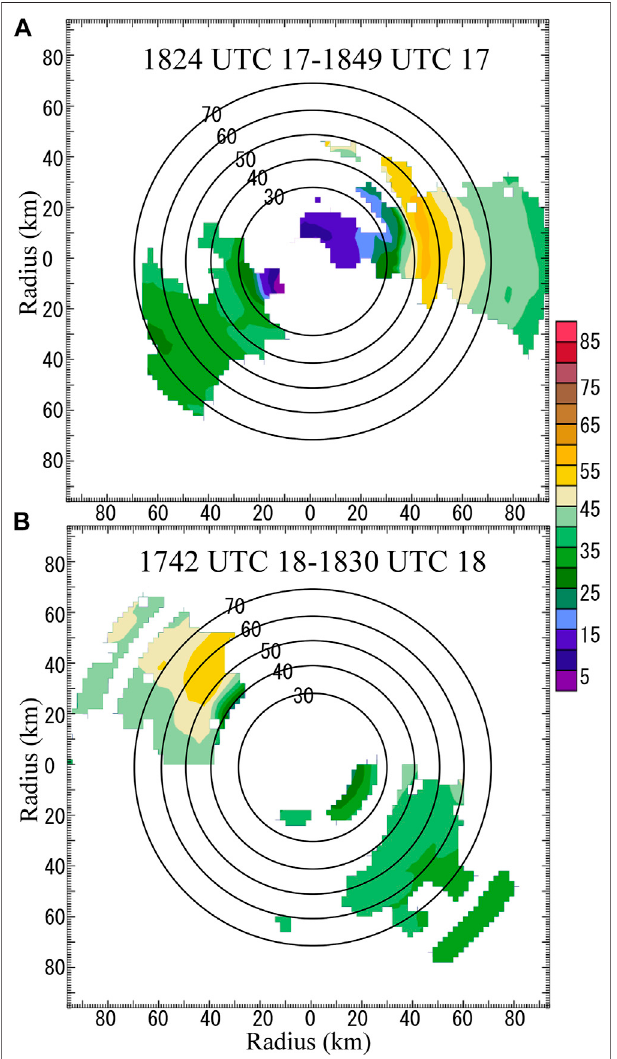
FIGURE 3 | Horizontal distribution of the 0.5-km wind (shaded, m s − 1 ) from the NOAA 42 Airborne Doppler radar for (A) 1824 – 1849 UTC Sep 17, 2006 and (B) 1742 – 1830 UTC Sep 18, 2006. Black circles indicate the radii from 30 to 70 km referring to the TC center. The fi gure is adapted from https://www.aoml.noaa.gov/hrd/Storm_pages/helene2006/radar.html. FIGURE 4 | Horizontal distribution of the surface wind (at the 10-m